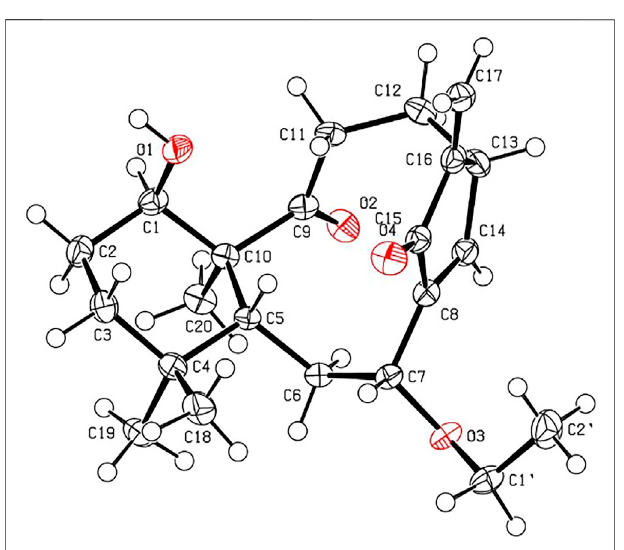
FIGURE 4 | X-ray ORTEP drawing of 1 (with a thermal ellipsoid probability of 30%).